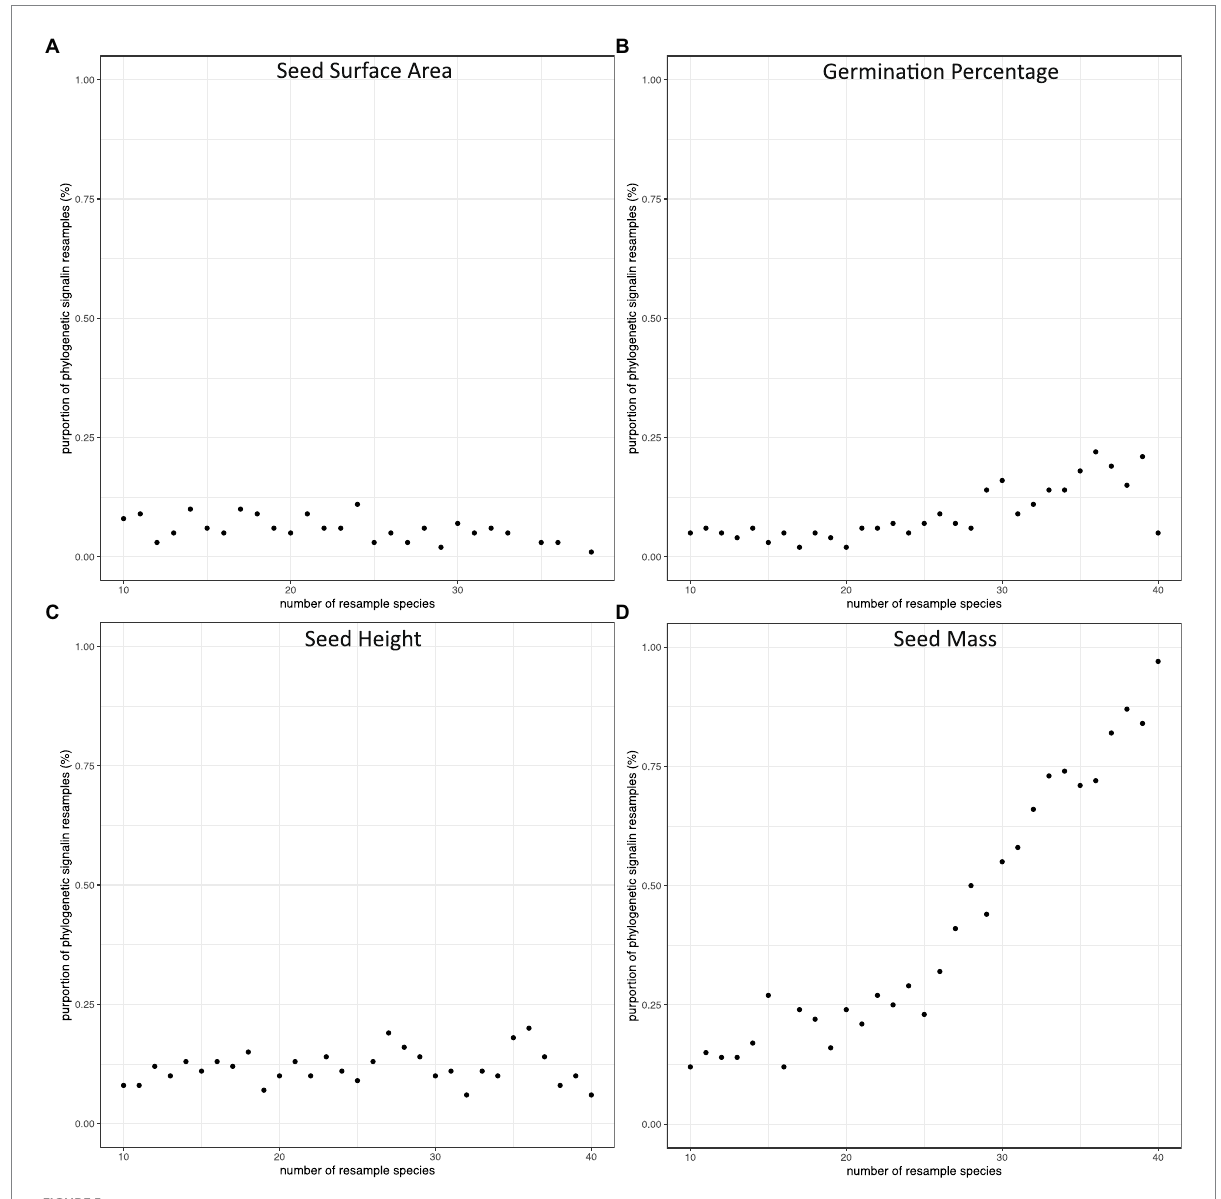
FIGURE 5 The proportion of subsamples with significant phylogenetic signals along the change of number of species in species pools. The species were resampled 100 times from 10 species to 40 species. The dots represent the proportion of Blomberg’s K value ( p =< 0.05) in each resampling